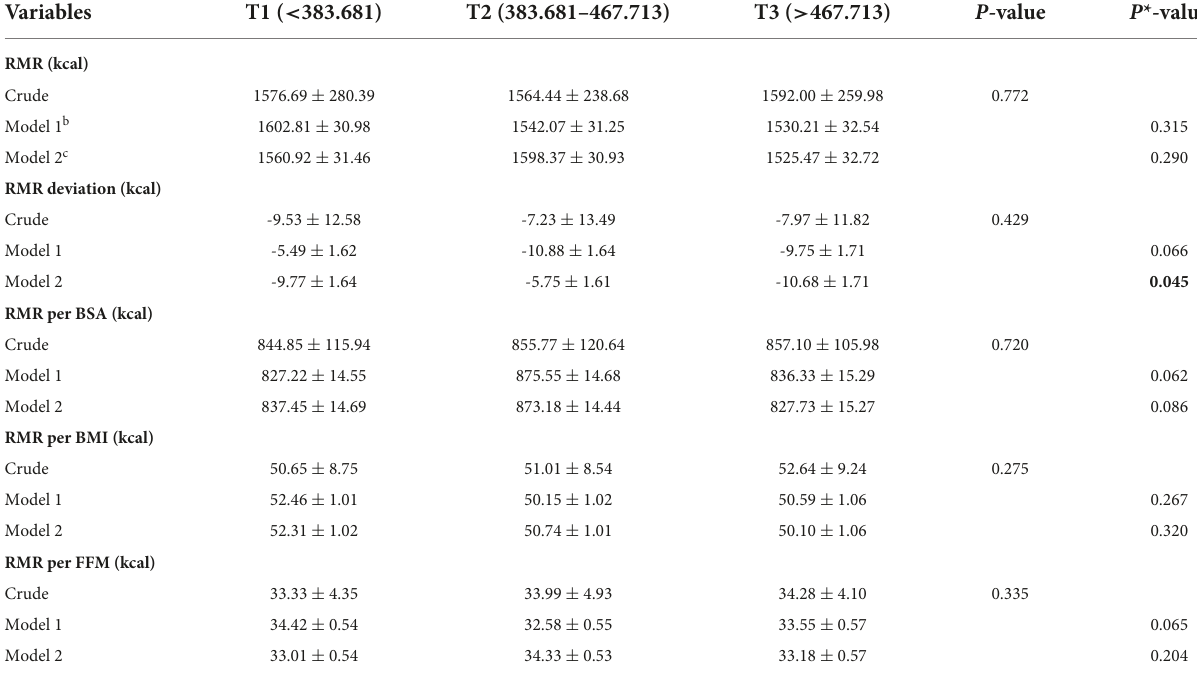
TABLE 3 The distribution of RMR subcategories between UPF intake